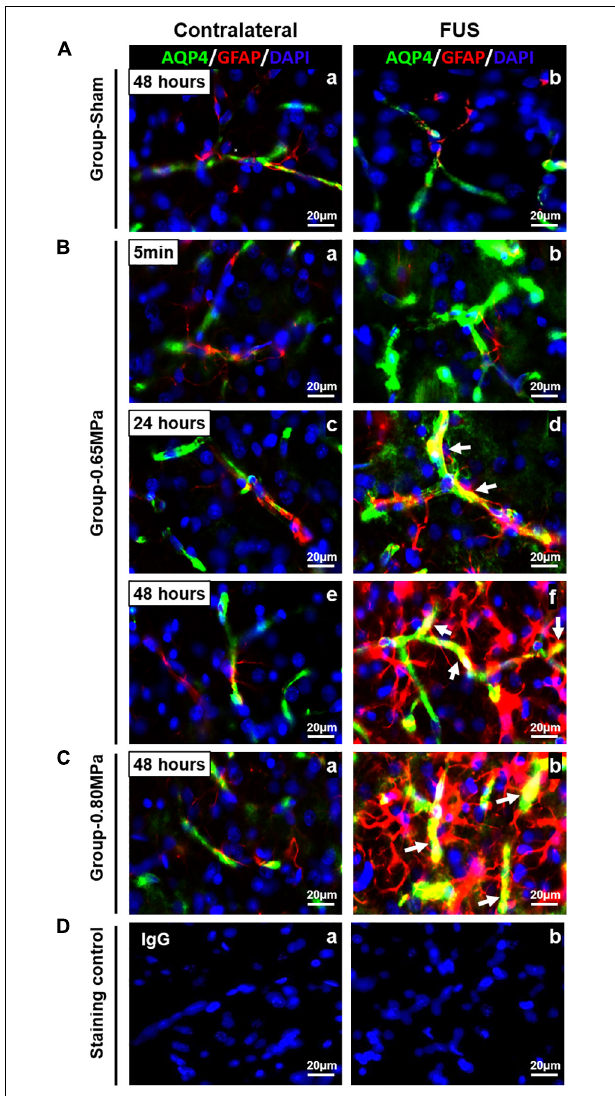
FIGURE 7 | Co-localization of AQP-4 astrocytic endfeet and GFAP in the FUS–BBBD region. Immunofluorescence staining for GFAP-positive astrocytes (red) and AQP astrocytic endfeet [green was performed in brain tissue for group-sham (A) , group-0.65 MPa (B) , group-0.80 MPa (C) , and staining control (D) ]. For group-0.65 MPa, we analyzed the changes of AQP-4/GFAP expression at multiple time points after FUS–BBBD. At 5 min, an increase of AQP-4 expression is shown that do not overlap with GFAP staining (Bb). At later time points after sonication, yellow colors in sonication region confirm co-localization of AQP-4 and GFAP (Bd, Bf, and Cb; white arrows). Contralateral regions are shown as a control. Blue fluorescence indicates the DAPI. Scale bar, 20 µ